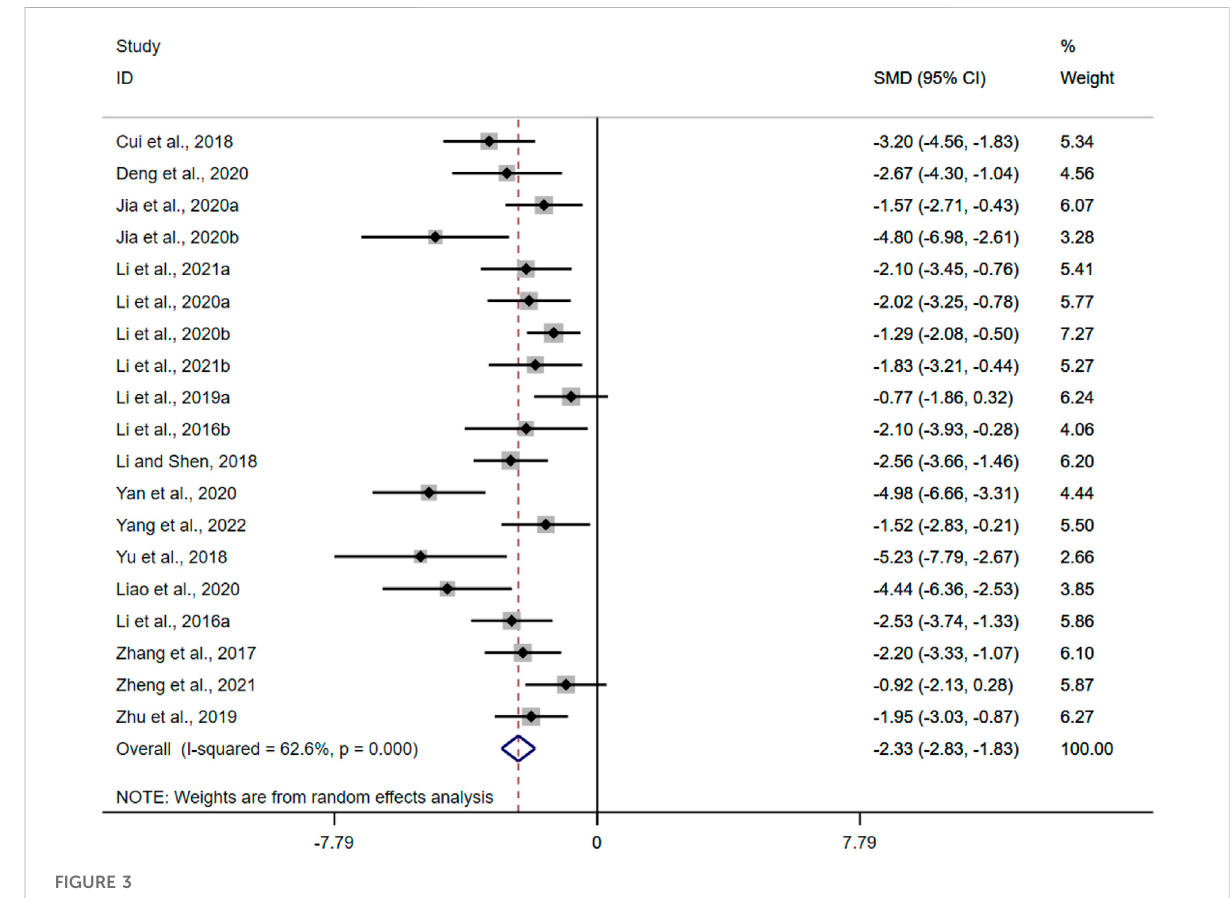
FIGURE 3 Forest plot: effect of berberine on HCS